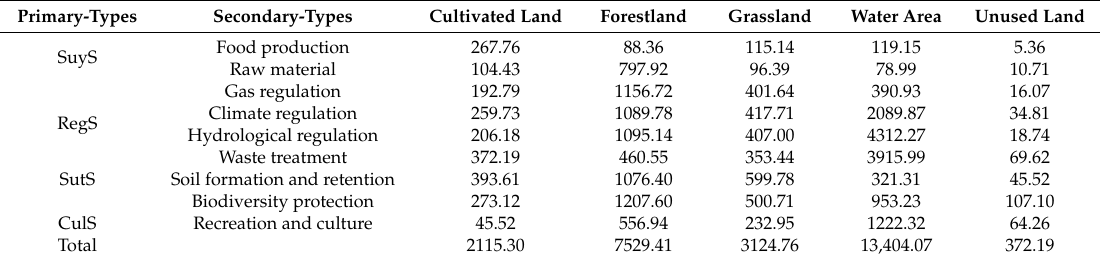
Table 1. The ecosystem service value (ESV) per land use type after correction in the